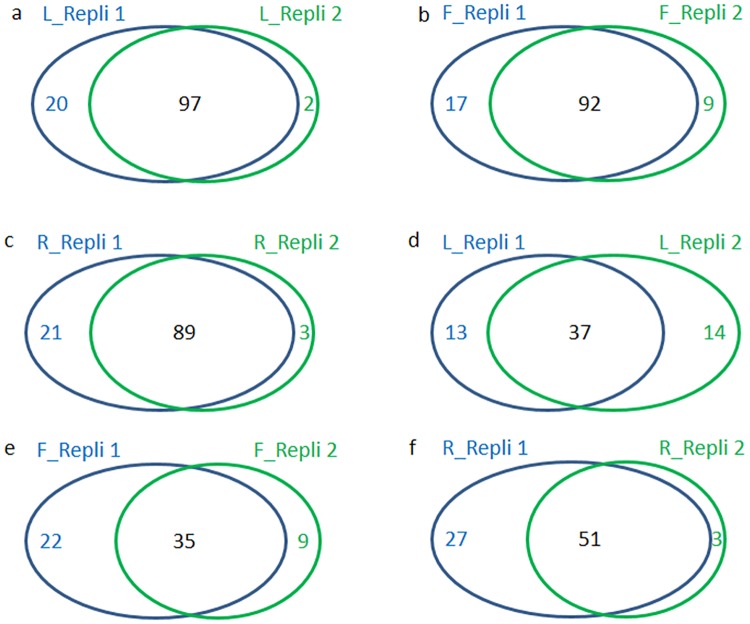
Number of the overlapped m6A transcripts in the two m6A-seq replicates.(a) in the leaf chloroplast; (b) in the flower chloroplast; (c) in the root amyloplast; (d)in the leaf mitochondria; (e) in the flower mitochondria; and (f) in the root mitochondria.